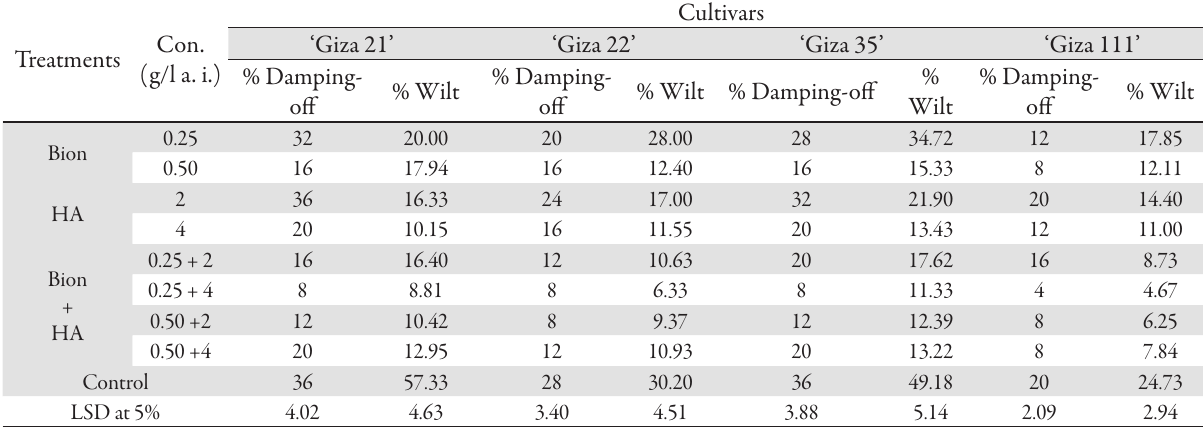
Tab. 2. Effect of BTH and HA on damping-off and wilt diseases caused by F. oxysporum isolate FO1 of the four soybean cultivars under greenhouse conditions Con. Treatments